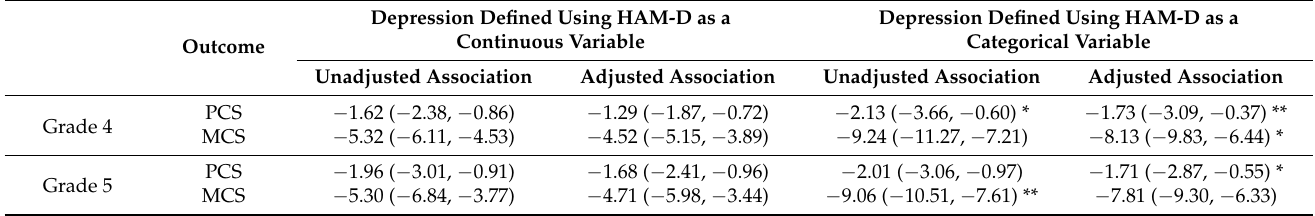
Table 5. Relationship between changes in physical and mental health-related quality of life health and depression